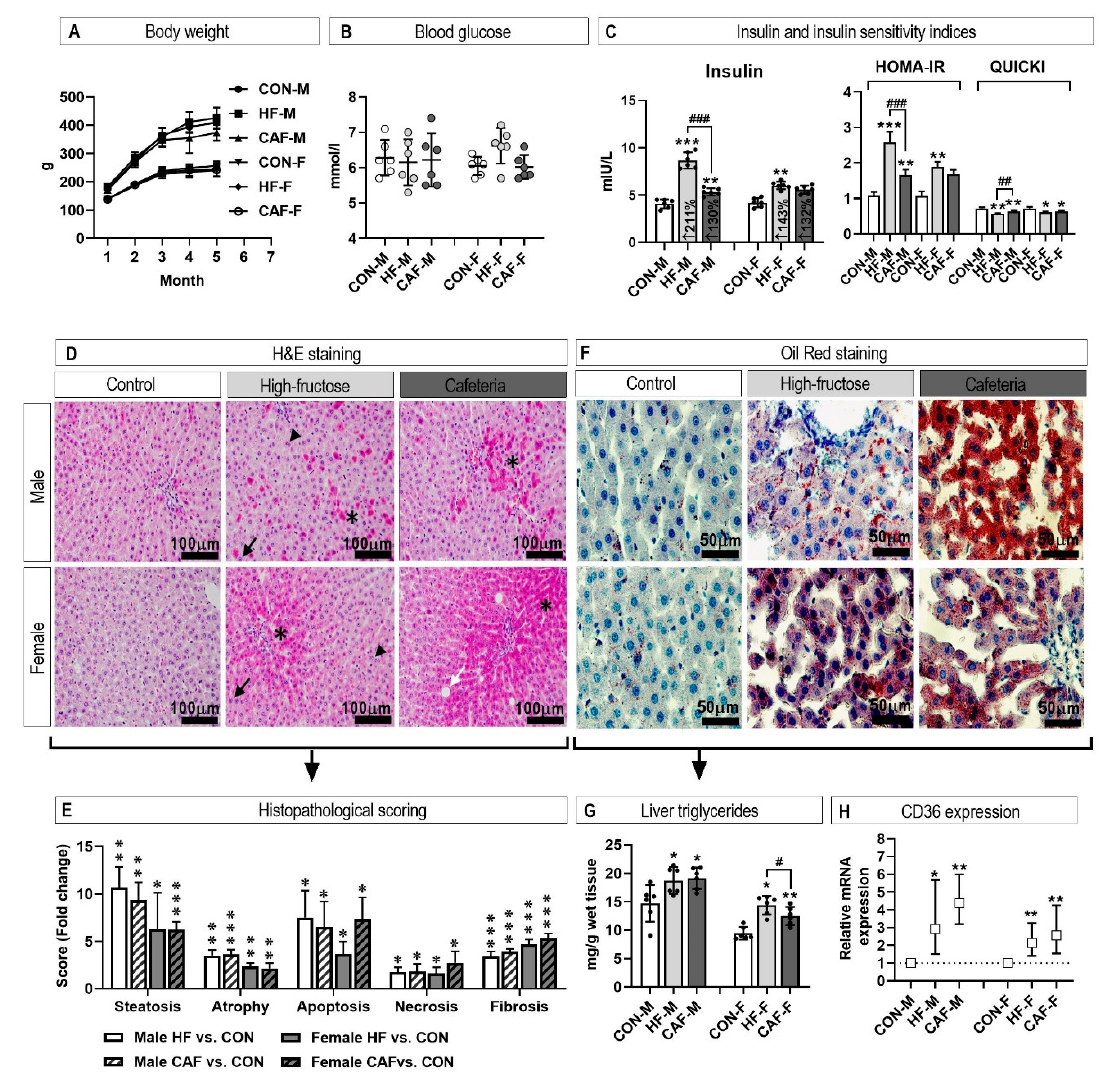
Figure 2. The influence of the treatments on body weight ( A ) and fasting blood glucose values ( B ). Insulin sensitivity was assessed as insulin concentration and insulin sensitivity indices, HOMA-IR and QUICKI ( C ). Photomicrographs of rat livers stained with hematoxylin and eosin (H and E) ( D ) and Oil-red ( F ). In High-fructose treated rats, note areas with apoptosis (asterisk), kariomegaly (arrow), and multinucleated hepatocytes (arrow head), and in Cafeteria diet treated rats, note areas with focal or diffuse apoptosis and necrotic cells (star) and focal macrovesicular steatosis (white arrow). Histopathological scoring is presented as fold change versus the control group ( E ). Lipid accumulation was further assessed by measuring hepatic triglyceride content ( G ) and hepatic CD36 expression. * p < 0.05, ** p < 0.01, *** p < 0.001 for the treatment versus the Control within the same sex. # p < 0.05, ## p < 0.01, ### p < 0.001 for the HF diet versus the CAF diet within the same sex. n = 6 for each group. CON, control diet; HF, high-fructose diet; CAF, cafeteria diet; M, males; F, females.